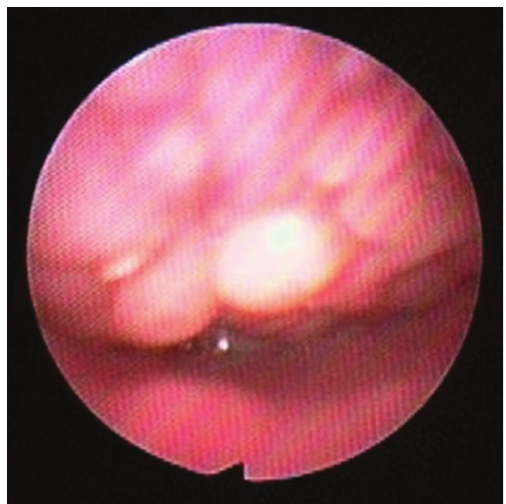
Figure 3: Tongue base collapsed against the posterior pharyngeal wall. The tip of the epiglottis is barely seen.